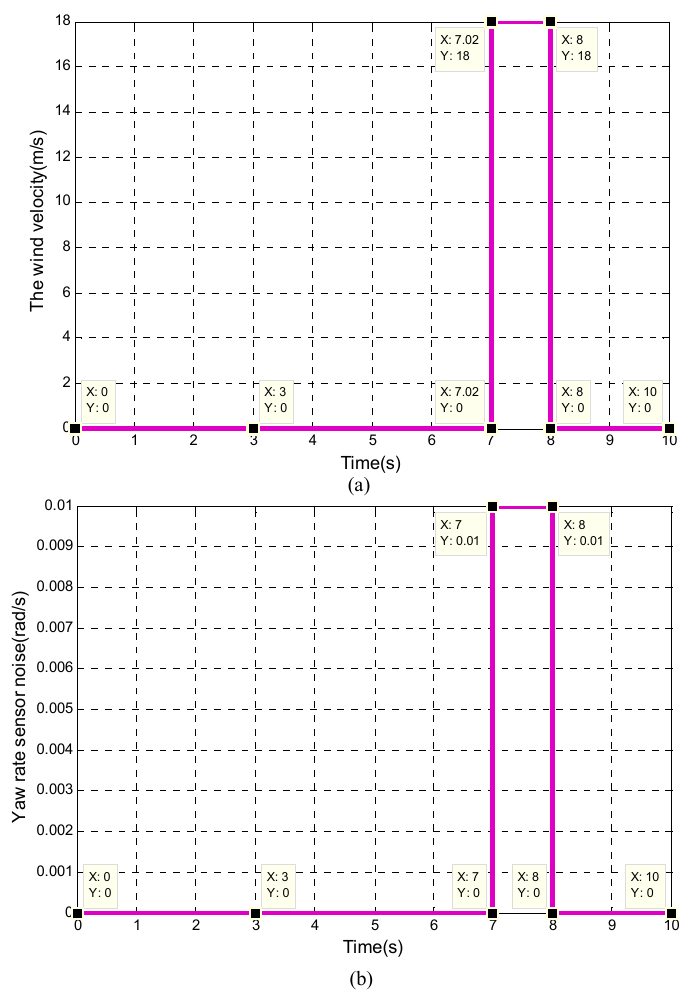
Figure 24. The disturbances inputs: ( a ) side wind; ( b ) yaw rate sensor noise.